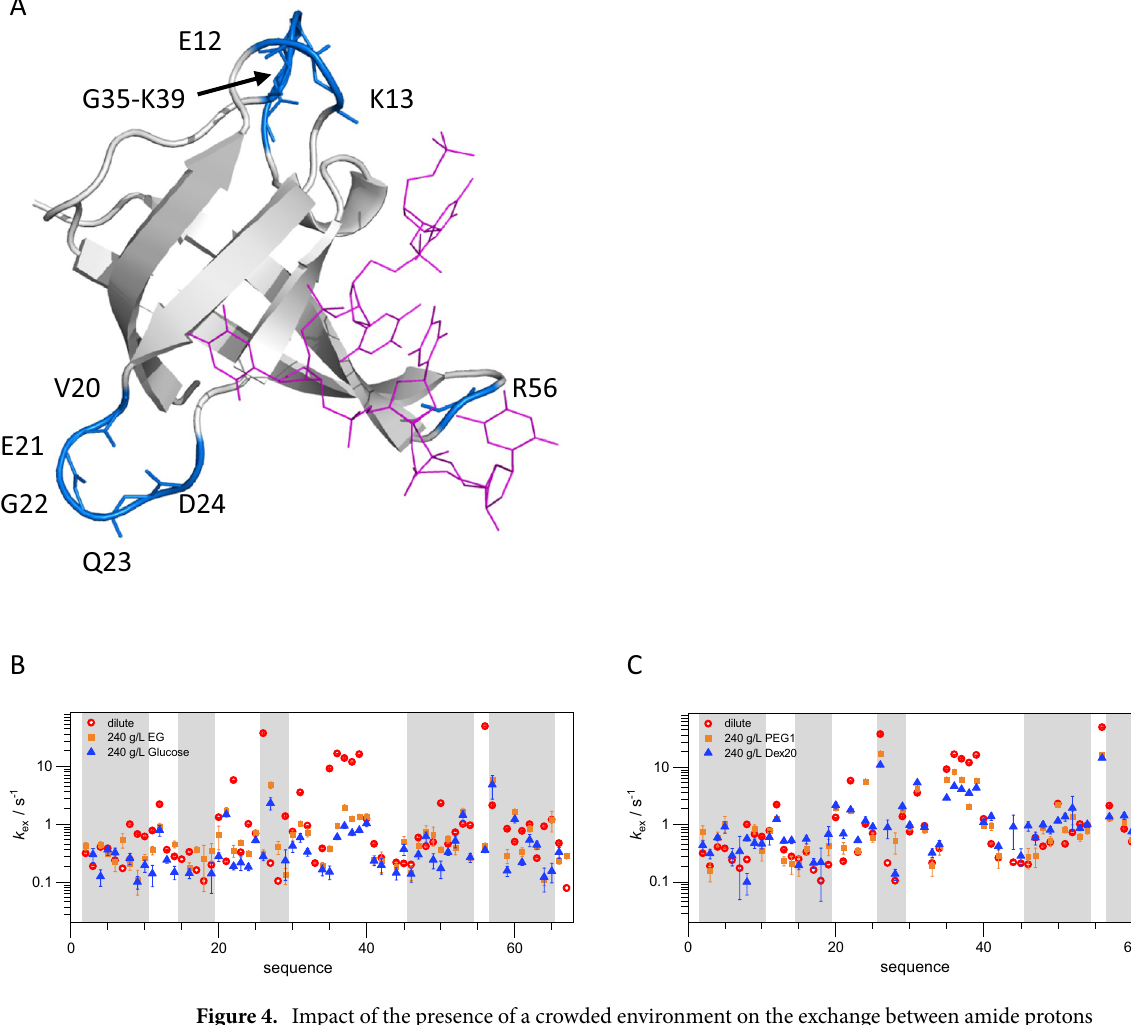
Figure 4. Impact of the presence of a crowded environment on the exchange between amide protons comprising Bs CspB with solvent protons as probed by NMR spectroscopy. ( A ) The backbone of Bs CspB is shown in cartoon mode (colored in gray) whereas dT6 is shown by using lines (colored in pink). Amide protons comprising Bs CspB which are highly affected upon adding of 240 g/L EG (colored in orange, rectangles, ( B )), 240 g/L glucose (colored in blue, triangles, ( B )) as well as 240 g/L PEG1 (colored in orange, rectangles, ( C )) or 240 g/L Dex20 (colored in blue, triangles, ( C )) in comparison to dilute conditions (colored in red, circles, ( B ) and ( C )) are highlighted by showing main chain atoms in stick mode (colored in blue). Associated data presenting residue specific buildup curves is shown in Fig. S9A–J. This figure has been prepared using 2ES2.pdb and PyMol (www. pymol.